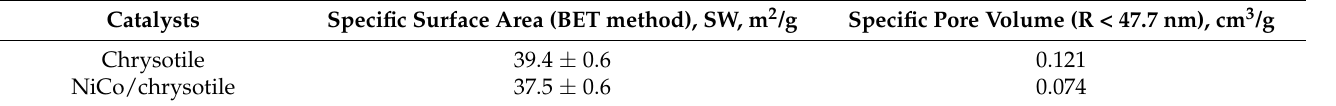
Table 3. Porosity characteristics of the leached chrysotile and the NiCo/chrysotile nanocatalyst. Catalysts Specific Surface Area (BET method), SW, m 2